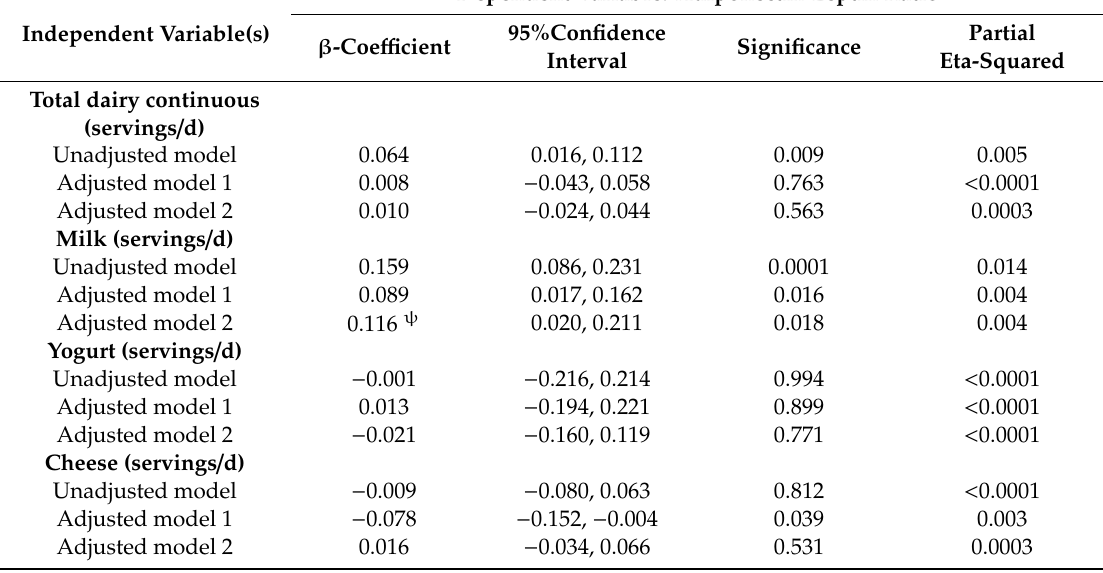
Table 4. Associations between total dairy, milk, yogurt, cheese consumption, and the adiponectin − leptin